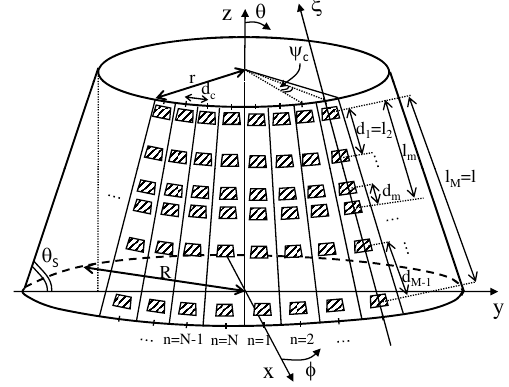
Figure 1. Sketch of the sparse CPA